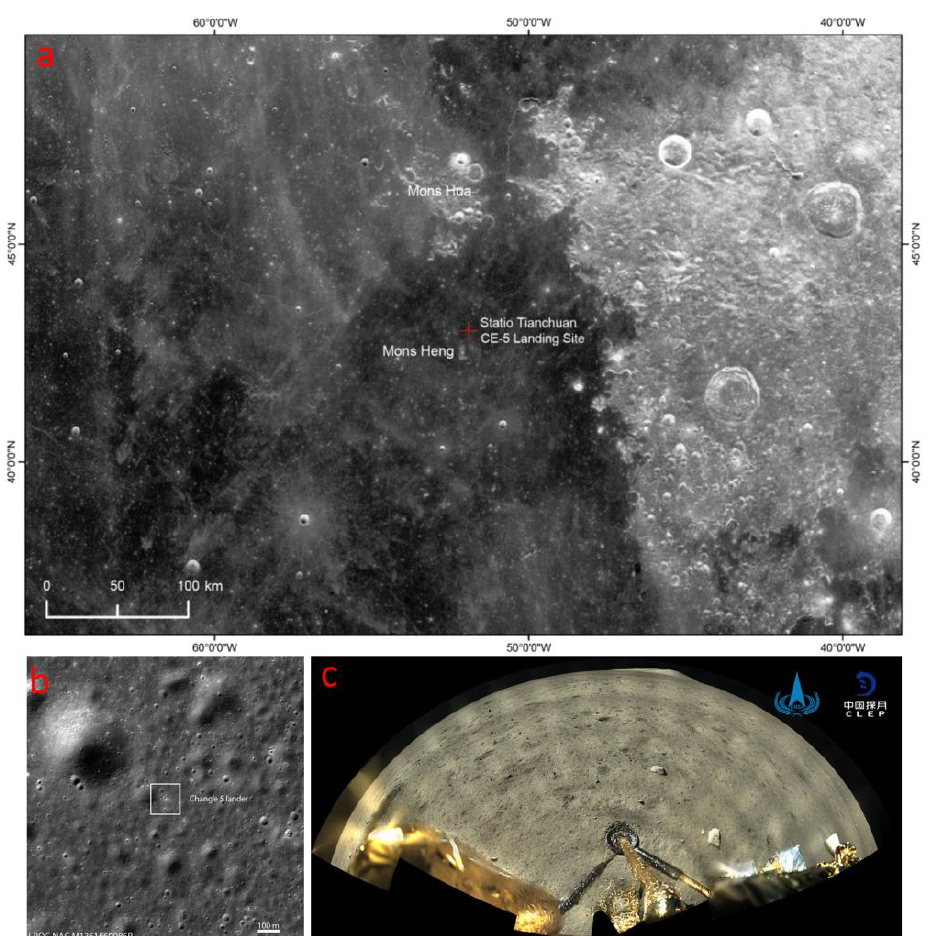
Figure 1. The landing area of CE-5. ( a ) The geologic context (the red cross is the location of CE-5 Lander) obtained by CE-2 Digital Orthophoto Map (DOM). ( b ) The landing site image obtained by the CE-5 lander camera (the white frame is CE-5 Lander). ( c ) The topography taken by the CE-5 panoramic camera.